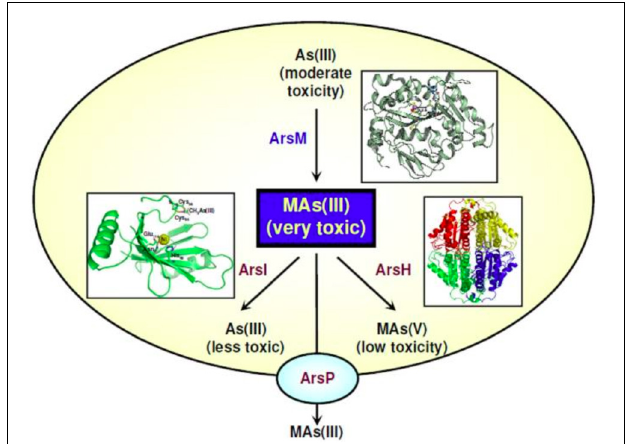
FIGURE 2 | MAs(III): a primordial antibiotic. In communities of soil microbes some bacteria such as Rhodopseudomonas palustris carry the arsM gene for the As(III) SAM methyltransferase, producing highly toxic MAs(III). This trivalent organoarsenical has antibiotic-like properties. Other soil bacteria carry genes for MAs(III) resistance. Some, such as Bacillus MD1, have the arsI gene for the ArsI C-As lyase enzyme that confers resistance to MAs(III) by degrading it into As(III) and formaldehyde. Yet other soil bacteria such as Pseudomonas putida have a gene encoding ArsH, a flavoprotein that uses NADP+ to oxidize